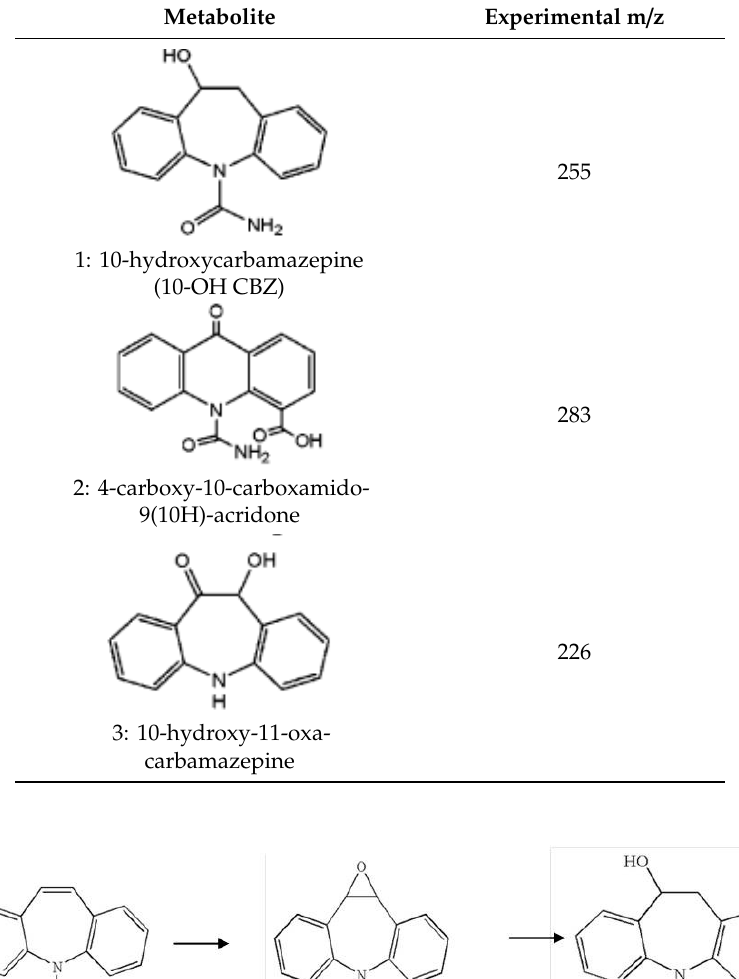
Table 4. CBZ metabolites detected by ultraperformance liquid chromatography-tandem mass spectrometry (UHPLC/MS/MS).